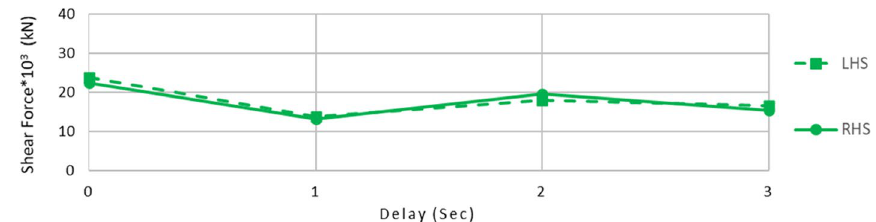
Fig. 11 Average shear force at tower